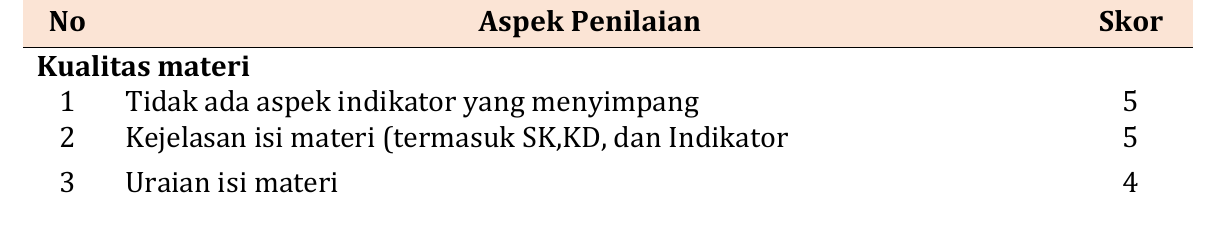
Table 2. Assessment Result by Material